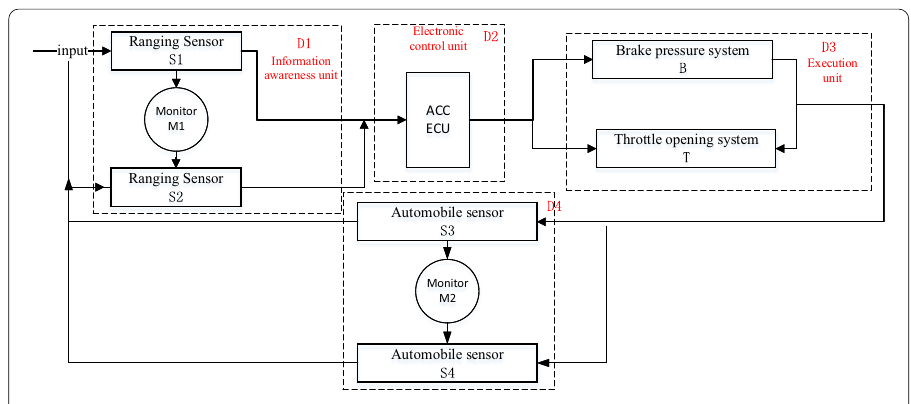
Fig.10 Schematic diagram of ACC